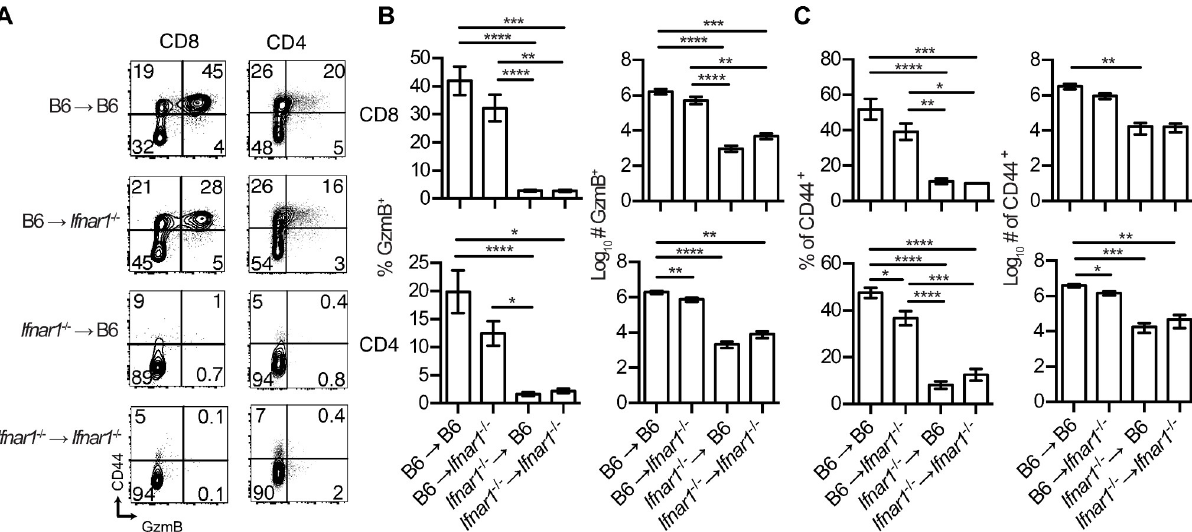
Fig 2. IFNAR in hematopoietic cells is necessary for efficient T cell responses to ECTV. BMC mice were infected as in Fig 1A , and spleens were harvested at 7 dpi. (A) Representative flow cytometry plots showing the frequency of CD44 + and GzmB + cells on gated CD8 T cells (NK1.1 - TCR β + CD8 + ) and on CD4 T cells (NK1.1 - TCR β + CD4 + ). (B) Percentages and numbers of cytotoxic GzmB + CD8 and CD4 T cells. (C) Percentages and numbers of antigen experienced CD44 + CD8 and CD4 T cells. Data are represented as mean ± SEM from three pooled independent experiments (N = 11 per group, N = 3 for Ifnar1 -/- ! Ifnar1 -/- , multiple comparison ANOVA with Tukey correction).